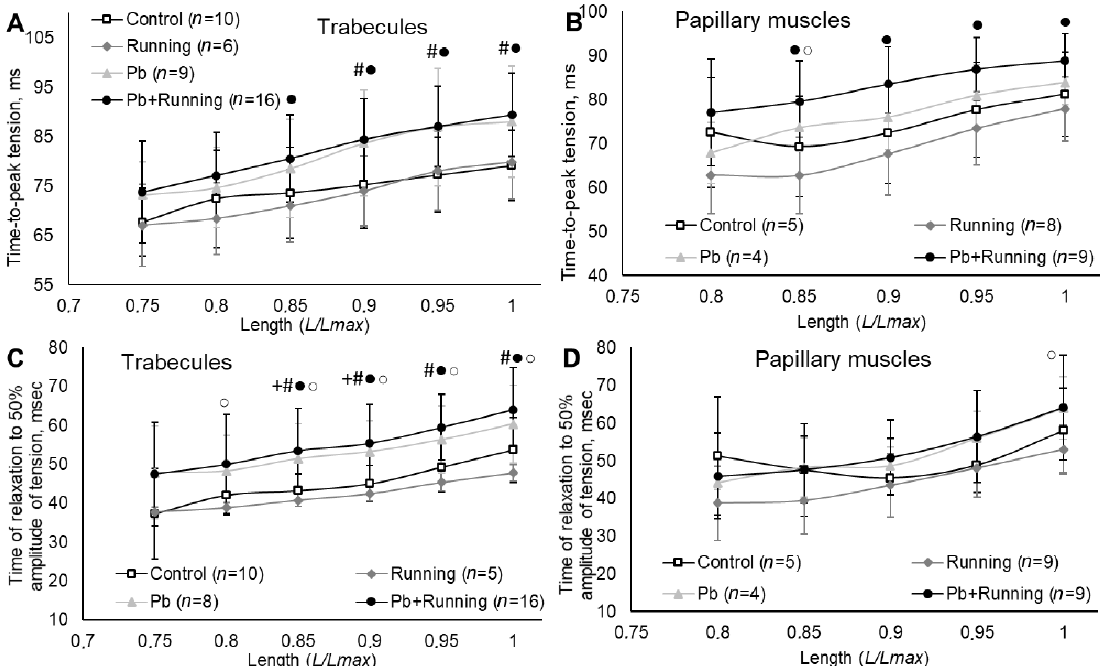
Figure 6. Isometric contraction time parameters of trabecules ( A , C ) and papillary muscles ( B , D ) in the experimental groups. The number of preparations is given in brackets. Muscle length is shown in Lmax units. Data are presented as mean ± S.D. There are significant differences (by Mann–Whitney U-test): *—”Running” vs. “Control”; +—”Pb” vs. “Control”; #—”Pb + Running” vs. “Control”; ● —”Pb + Running” vs. “Running”; ○ —”Pb” vs. “Running”.